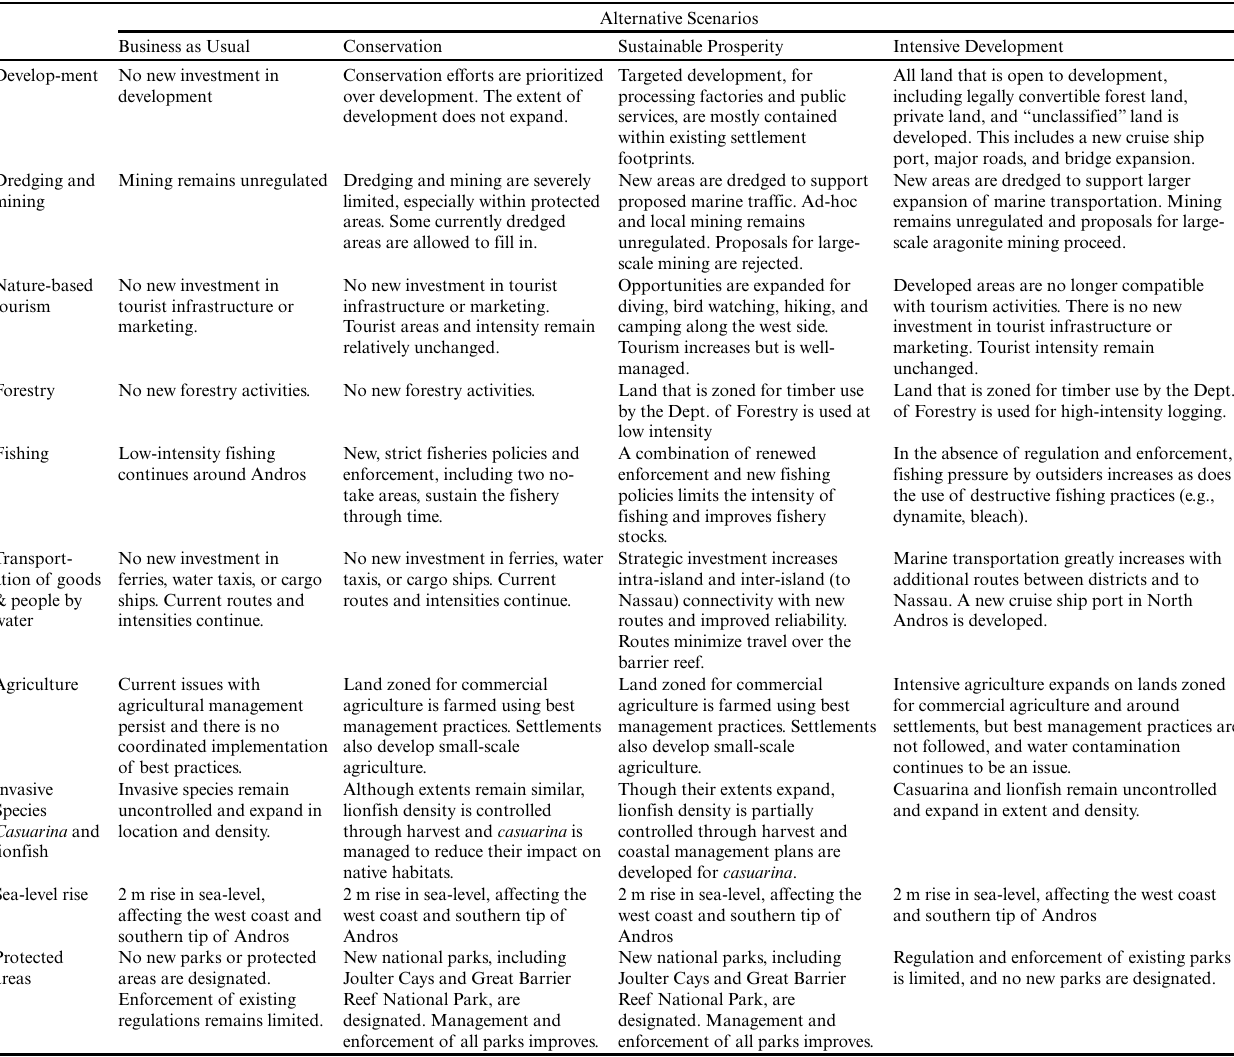
Table 1 . Activity-specific narratives for each scenario. These were developed from community members and ministry input, providing further detail to the overarching scenario narratives. Activity-specific details were checked with local, regional, and global experts to ensure they were plausible. The extent of each activity is represented spatially in scenario maps. Activity-specific narratives informed exposure and consequence scores (e.g. intensity, management effectiveness) in habitat risk assessment